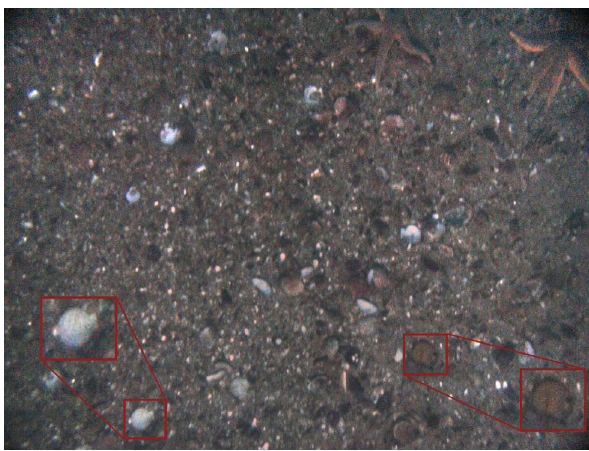
Figure 2. An enhanced color digital image of a scallop bed in Breidafjordur, Iceland, collected from the Gavia autonomous underwater vehicle. The image was taken at 1.96 m above the bottom and 28.9 m depth with a pitch and roll of 0.6 and 2 deg. The bottom right corner shows an enlargement of a live scallop. The bottom left corner shows an enlarged dead scallop shell that has decolorized.